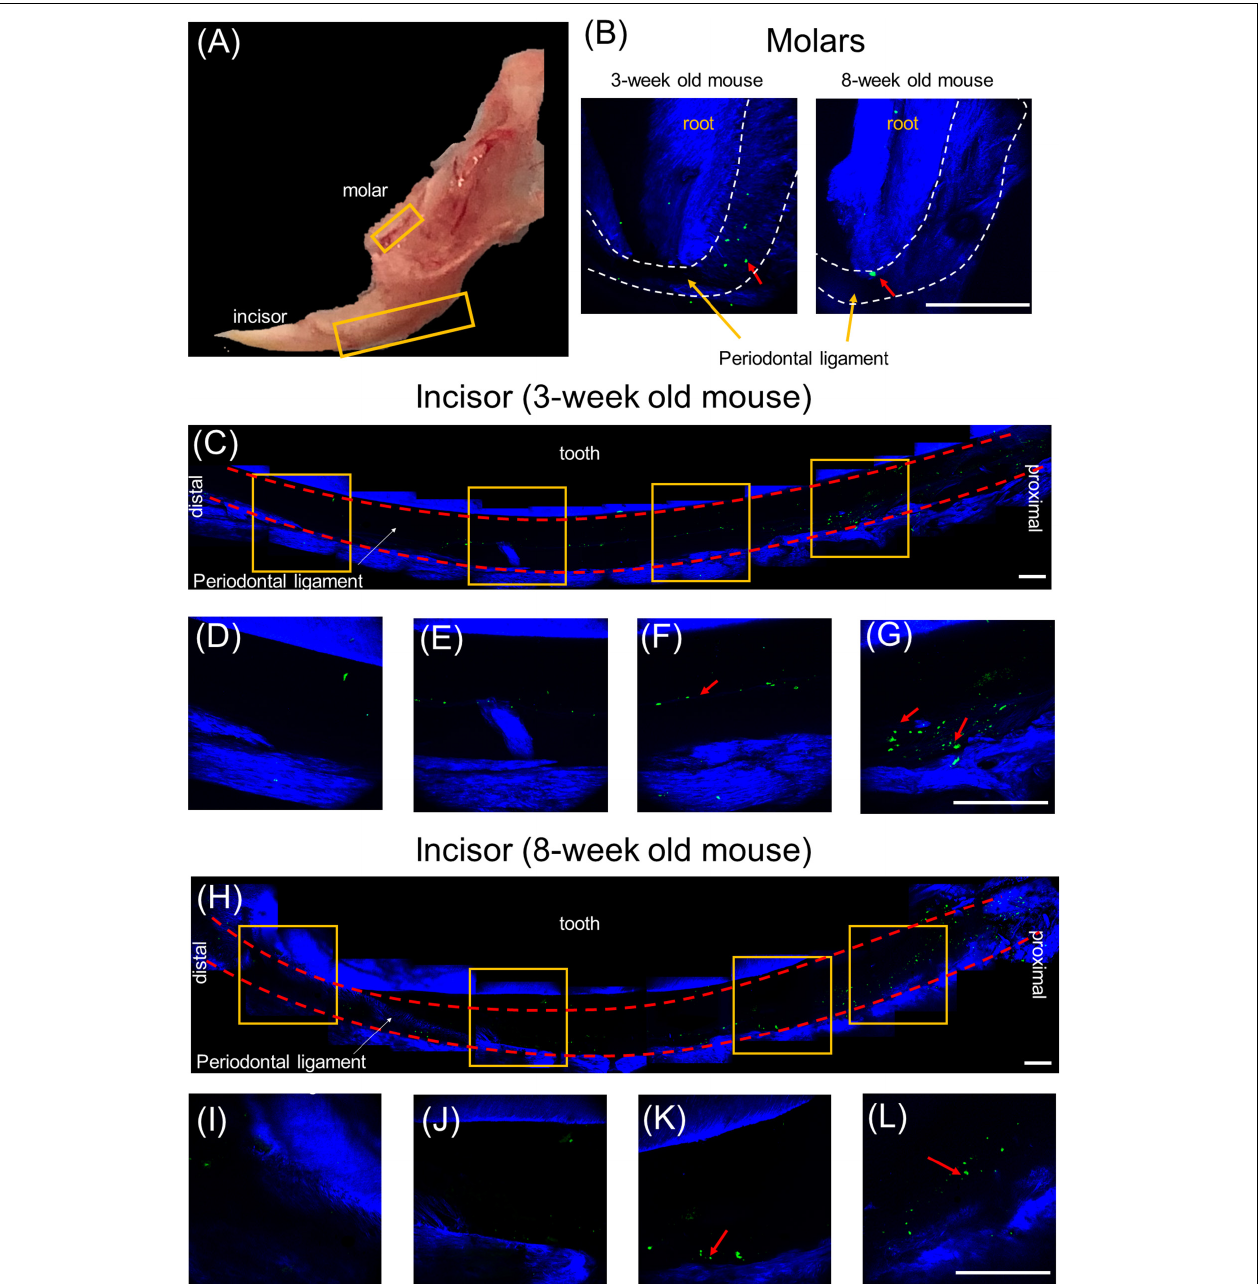
FIGURE 2 | Multiphoton intravital microscopy images of pnPRX1 + cells in mice periodontal ligaments. The pnPRX1 + cells (green) express GFP and the bones and tooth (blue) were visualized by their SHG signals. (A) Fresh harvested mouse mandible bone; (B) multiphoton images of periodontal ligaments of a 3-week old and 8-week old mouse molars. Dashed white lines demark PDL space boundary; (C) multiphoton images of lower periodontal ligaments of a 3-week old mouse incisor; (D–G) zoomed-in images of the lower mouse incisor periodontal ligament corresponding to the labeled gold squares in (C) ; (H) multiphoton images of lower periodontal ligaments of a 8-week old mouse incisor; (I–L) zoomed-in images of the lower mouse incisor periodontal ligament corresponding to the labeled gold squares in (H) . The scale bars are 200 µ m. The red arrows point at pnPRX1 +